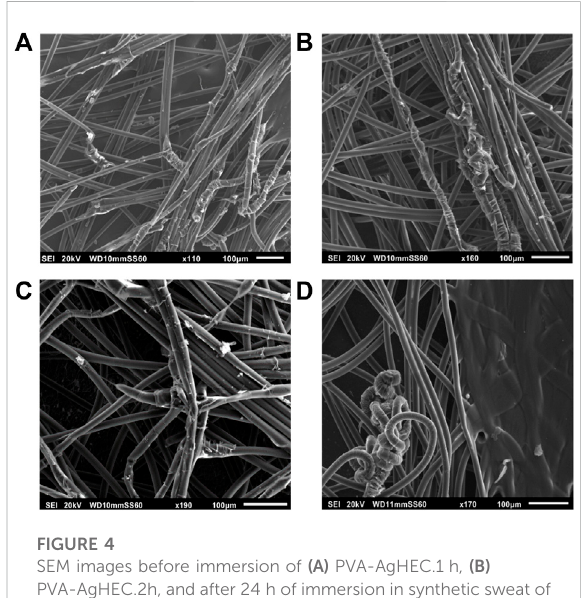
FIGURE 4 SEM images before immersion of (A) PVA-AgHEC.1 h, (B) PVA-AgHEC.2h, and after 24 h of immersion in synthetic sweat of (C) PVA-AgHEC.1 h and (D) PVA-AgHEC.2